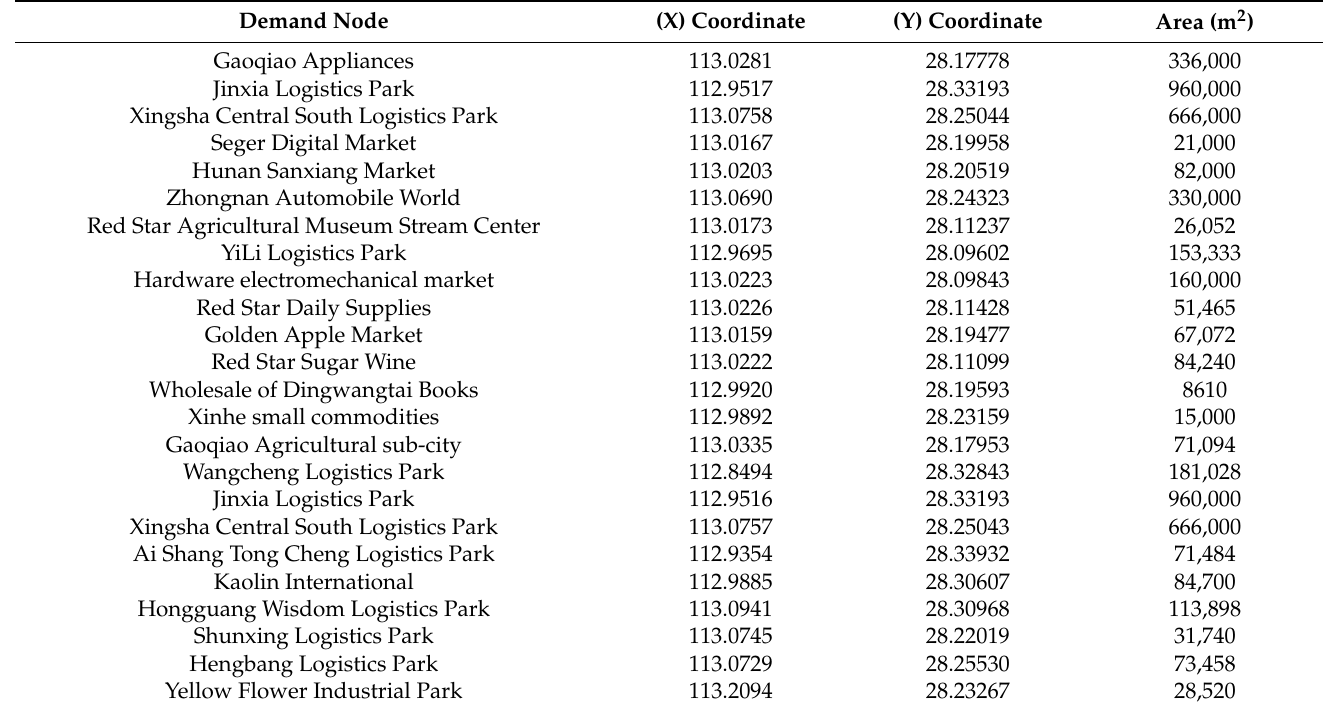
Table 3. Requirements for node information